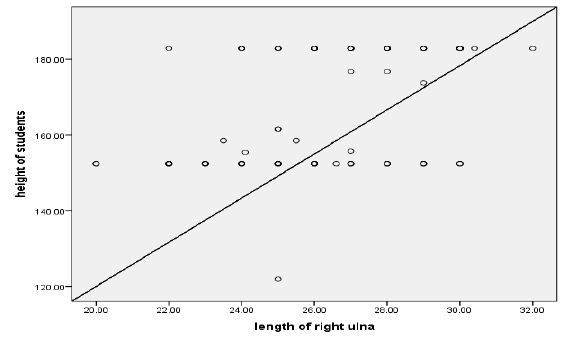
Fig. 2. Correlation of Height with length of right ulna in both sexes